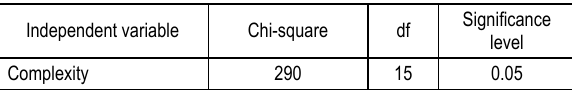
Table 4. The results of test of the relationship between complexity of solar water heater and adoption Independent variable Chi-square df 290